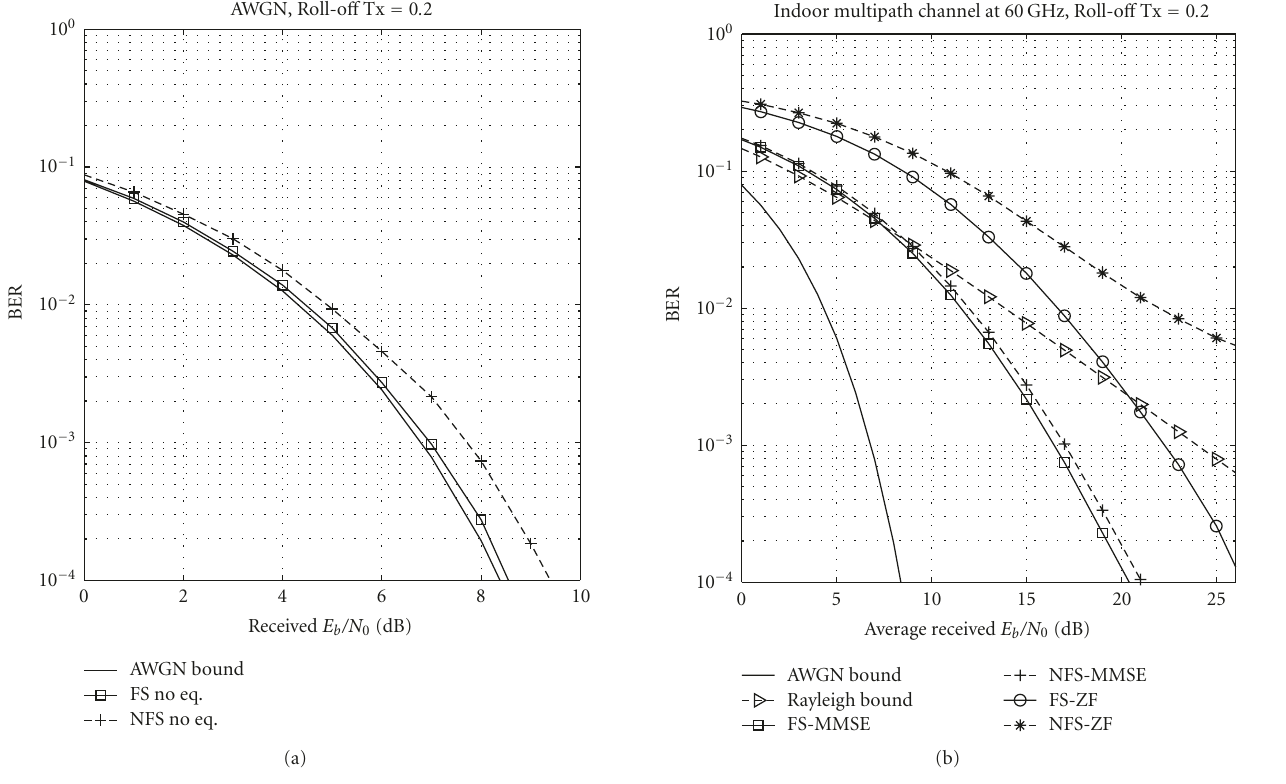
Figure 10: Uncoded BER performance of OQPSK with FDE for di ff erent receivers.